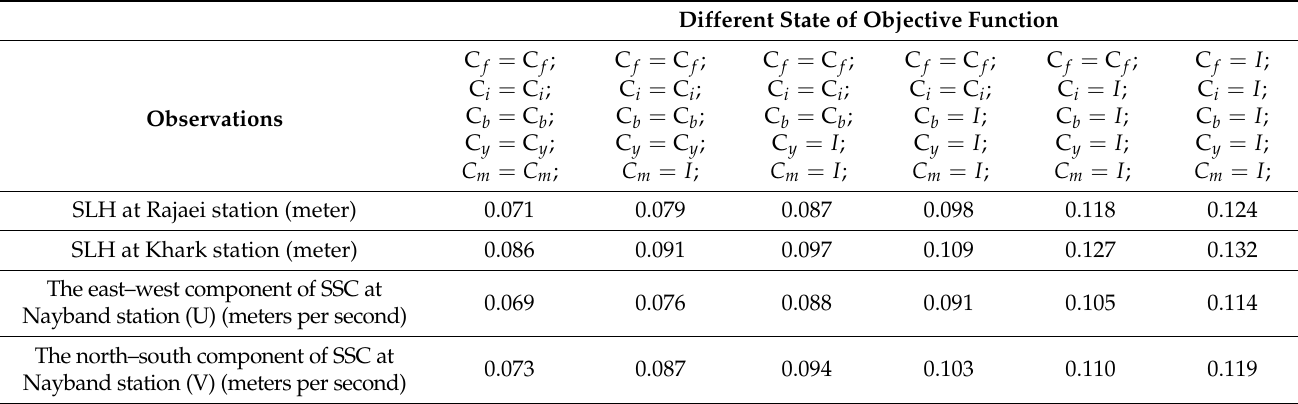
Table 5. RMSE values between the assimilated (calibrated) model and tide gauge observations at Rajaei and Khark control stations and current meter observation at Nayband control station. Different State of Objective